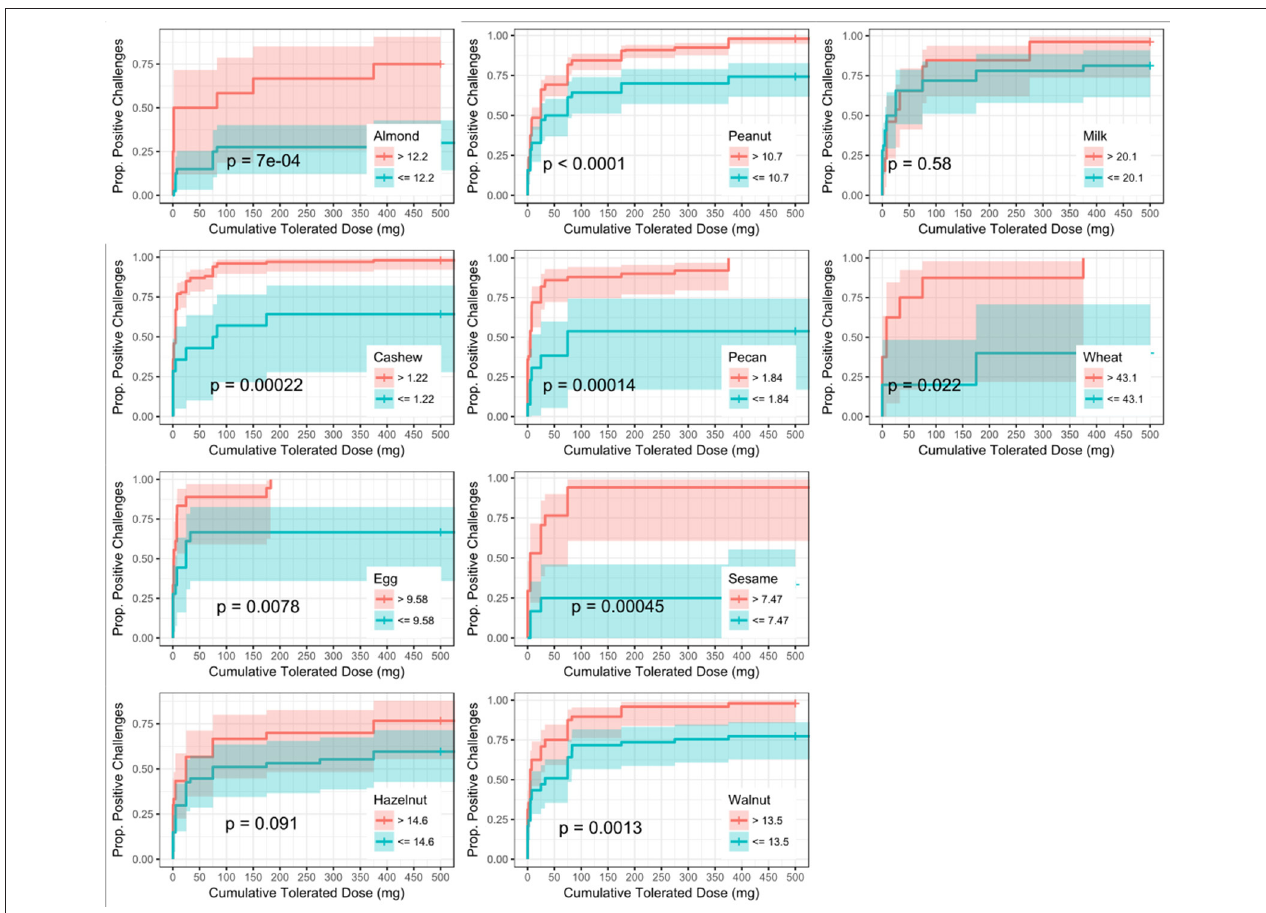
FIGURE 5 | Dose to positive challenge by allergen-specific IgE (sIgE) threshold and food. Kaplan-Meier curves of dose to positive challenge stratified by the CTD-dependent ROC thresholds for sIgE by food. Red lines indicate risk of a positive challenge if sIgE is above the threshold, while blue lines indicate risk for participants with sIgE at or below the